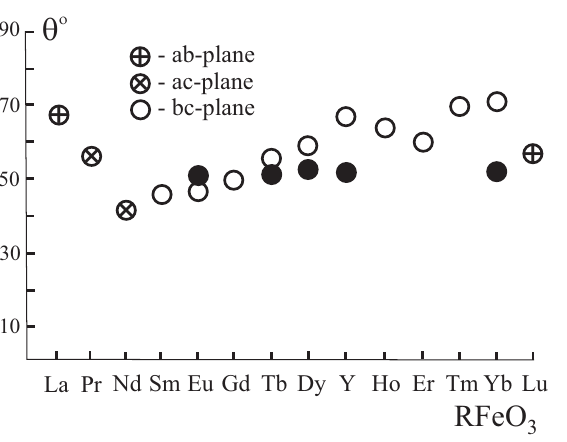
Figure 9. The orientation angles ( ± θ ) of optical axes in respective planes of orthoferrites predicted by the deformation model. The solid black circles are scarce experimental data for bc plane (see text for